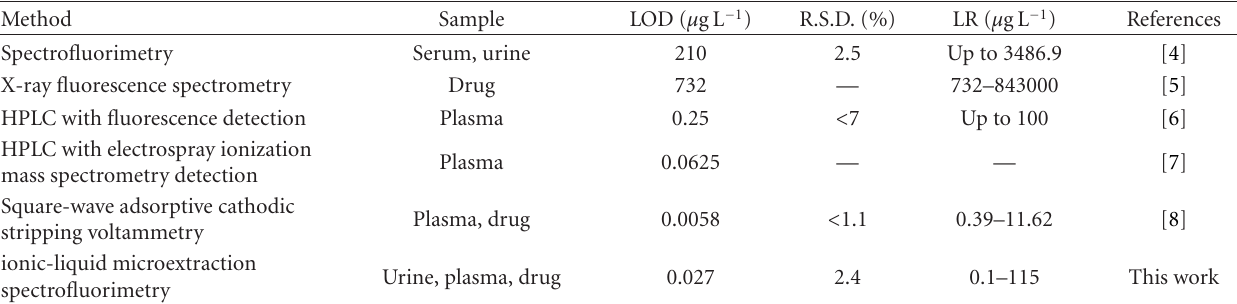
Table 4: Comparison of the proposed approach with other reported methods for determination of